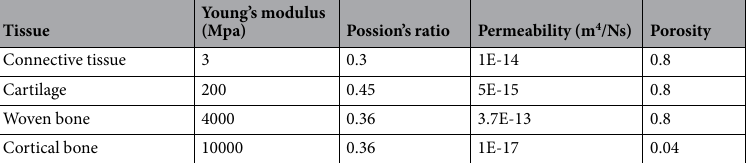
Table 3. Material properties of connective tissue, cartilage, woven bone and cortical